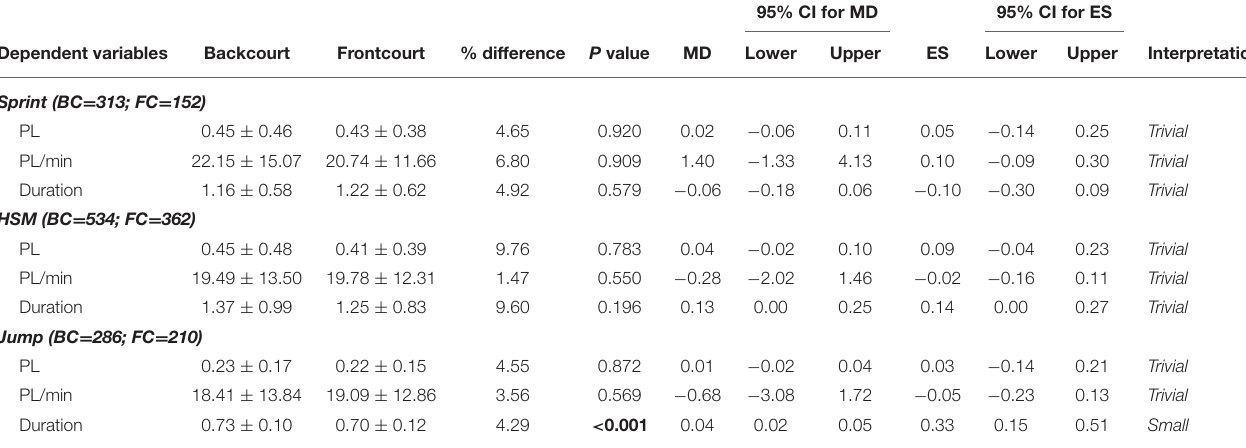
TABLE 3 | Differences in PL, PL/min and duration for all activity patterns between backcourt and frontcourt positions.